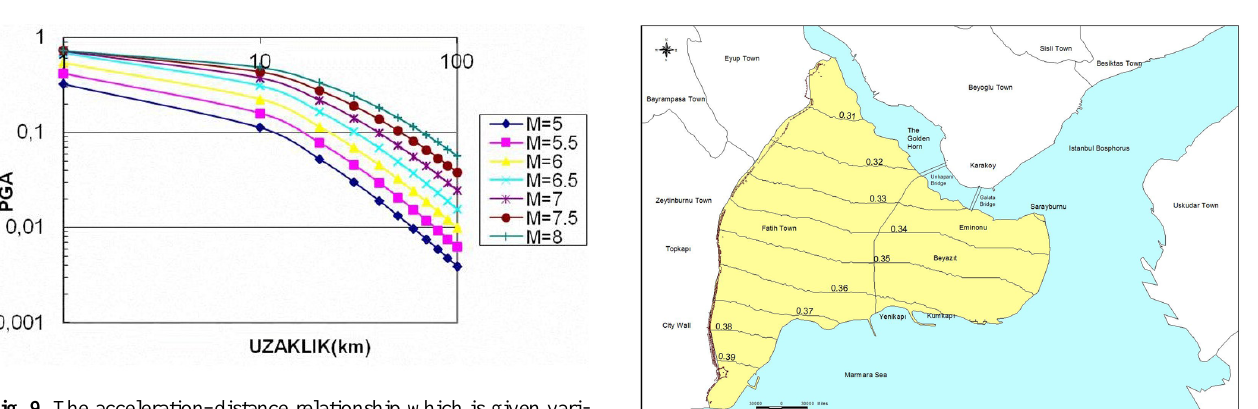
Fig. 9. The acceleration–distance relationship which is given vari- ous magnitude values according to Sadigh et al. (1997).